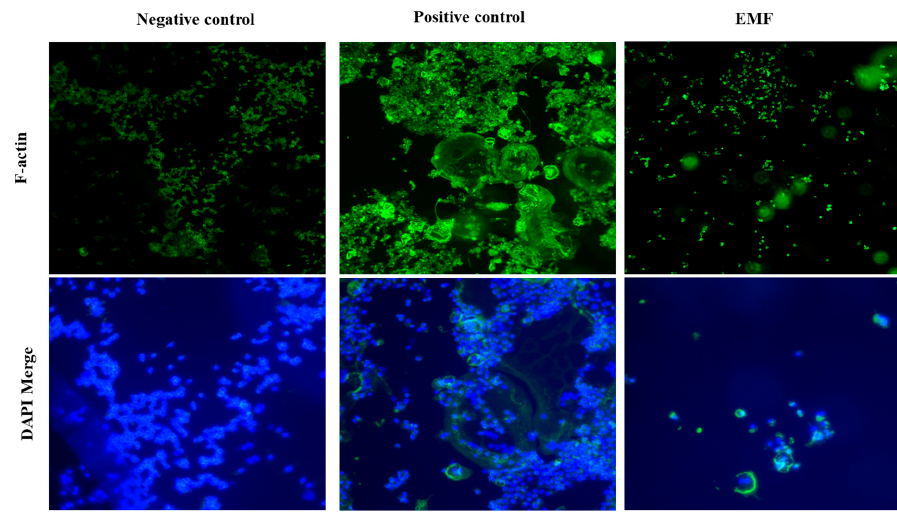
Figure 3. EMF-modulated actin formation. FITC-conjugated phalloidin staining in Raw 264.7 cells differentiated into osteoclasts for 4 days in differentiation media (with 50 ng/mL RANKL) with or without EMF exposure. The images were acquired at 100× magnification. Negative control, cells grown in growth media (undifferentiated); positive control, cells grown in differentiation media (with RANKL); EMF, cells grown in differentiation media (with RANKL) with EMF exposure.